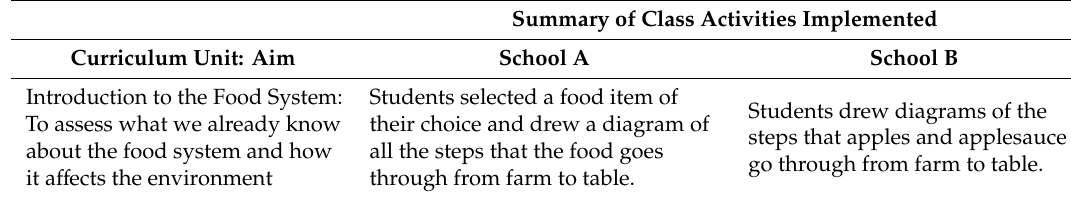
Table 2. Intervention implementation summary by